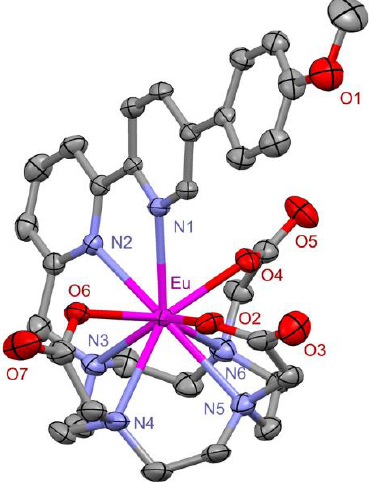
Figure 1. X-Ray diffraction data for the Eu • 4b complex [19]. Reprinted with the permission of [19]. Copyright © 2011 Elsevier B.V.